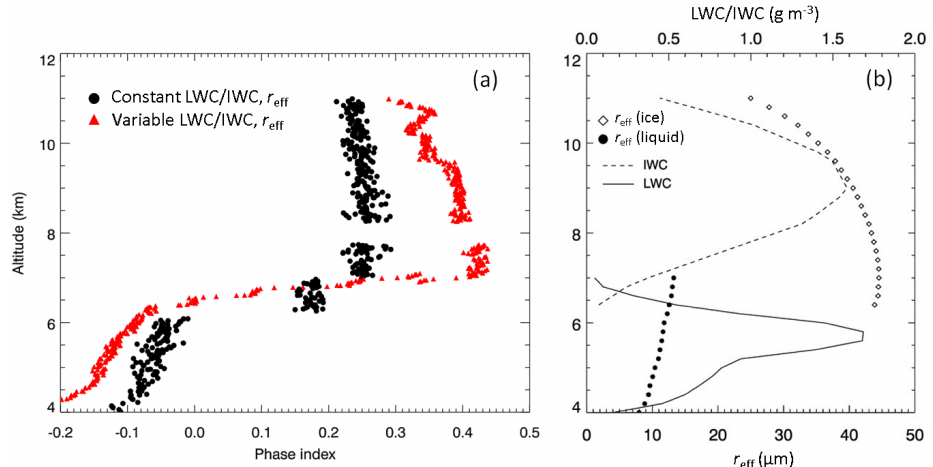
Figure 4. (a) Phase index derived for simulated clouds with variable LWC/IWC and effective radius and fixed values of microphysical properties. (b) Profile of corresponding cloud with variable LWC/IWC and r eff